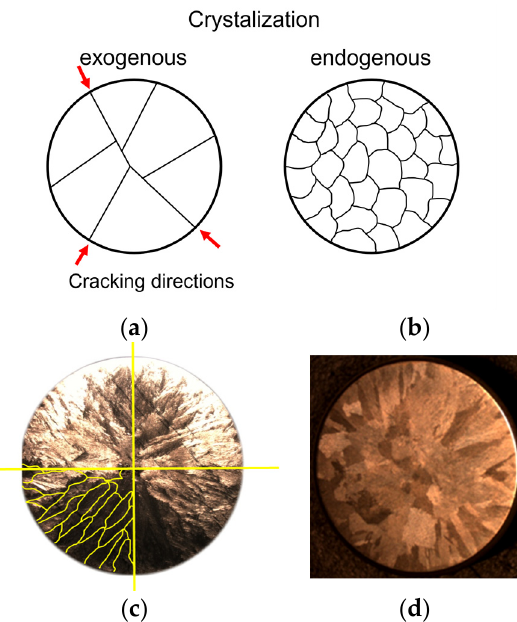
Figure 1. ( a ) Scheme [22,23] of coarse-grained microstructure formed during directional crystallisation with direction of cracking; ( b ) fine-grained microstructure formed during volumetric crystallisation; ( c ) surface of a metallographic specimen made of high-chromium cast iron with revealed directed macrostructure of grains of primary austenite with grain boundaries (marked with grain boundaries); ( d ) appearance of a sample made of the same cast iron but with equiaxed grains of primary